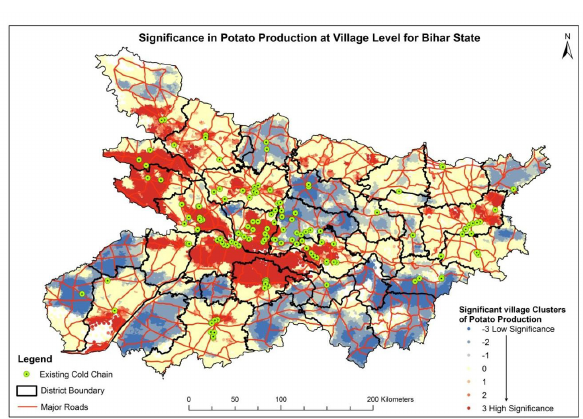
Figure 9. Significance map for the potato crop, prepared based on the potato crop proportion map